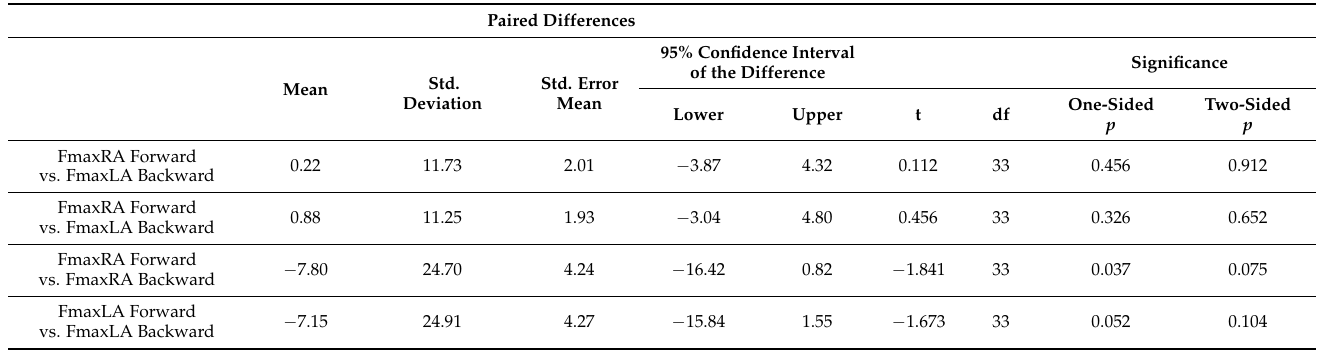
Table 4. Paired sample t